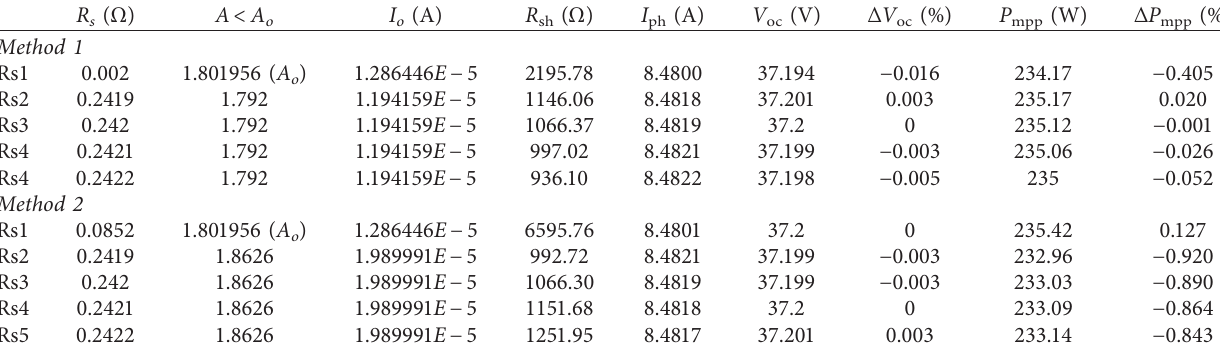
Figure 4: An algorithm for evaluating the A I o opt , I o , R sh , and R s using manufacturer’s datasheet. o , A , Table 2: Extracted parameters and data from simulations for